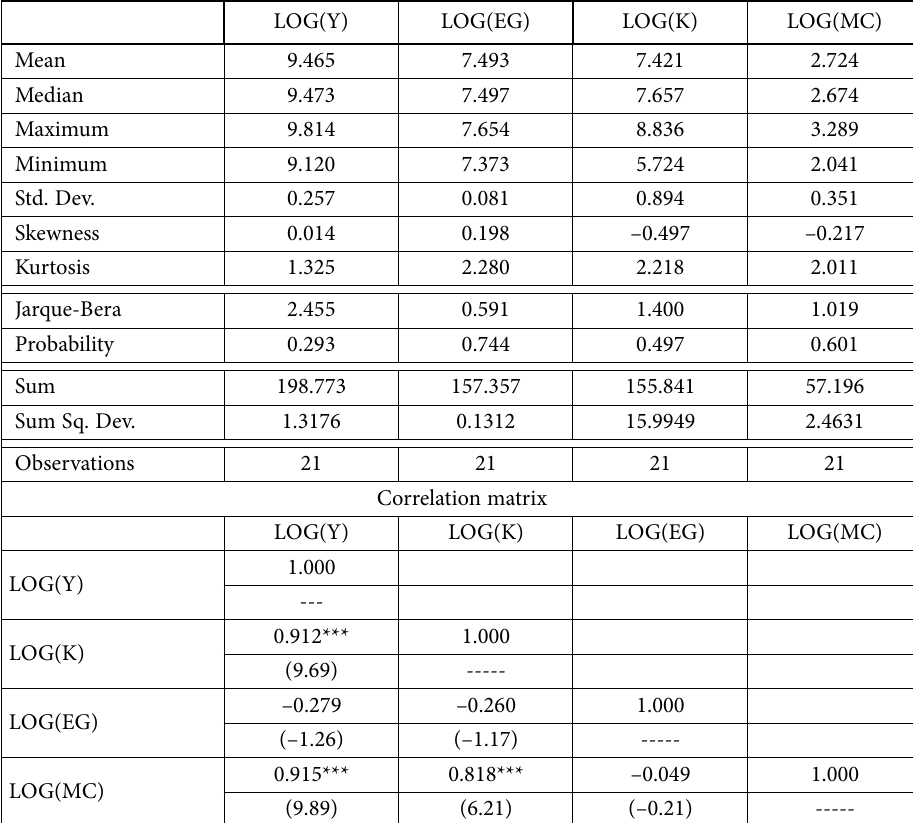
Table 2. The descriptive statistics and the correlation matrix of the datasets (source: authors’ processing based on WBD, Eurostat, ILO and NIS